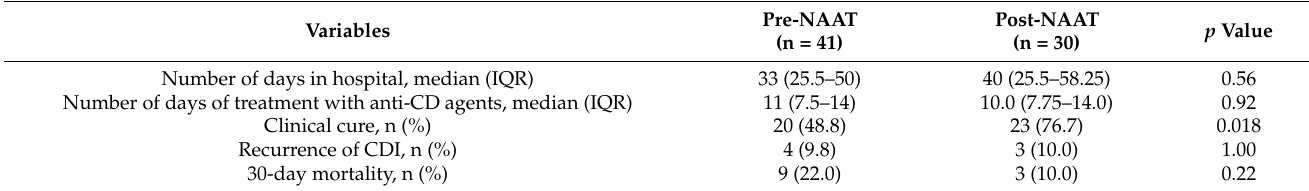
Table 2. Comparison of clinical outcome between pre-NAAT group and post-NAAT